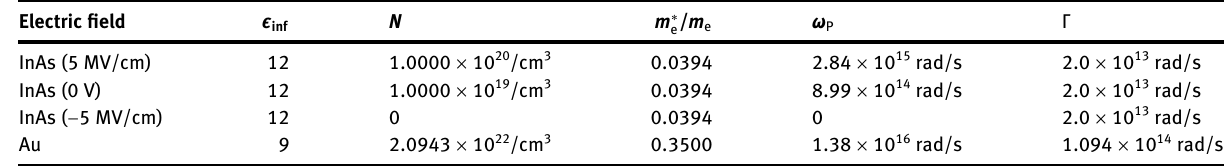
Table  : Parameters used for the Drude ’ s model with the charge concentration ( N ) from the electrical simulation and the material properties ( ϵ inf , m ∗ / m e , and Γ ) from the previous empirical study in [  ]. e Electric fi eld ϵ inf N m ∗